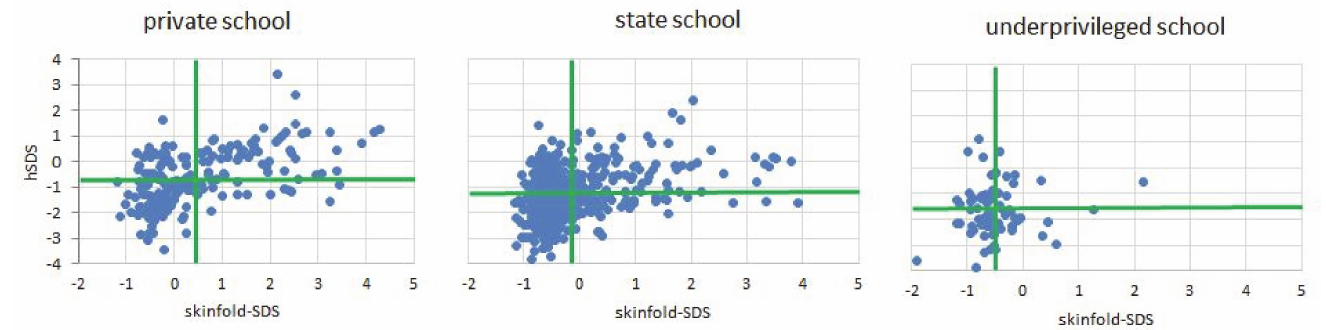
Figure 1. Height (hSDS) and skinfold thickness (skinfold-SDS) of the children from the private school, state schools, and the underprivileged school in Kupang (West-Timor, Indonesia). Green bars indicate mean values of hSDS and skinfold